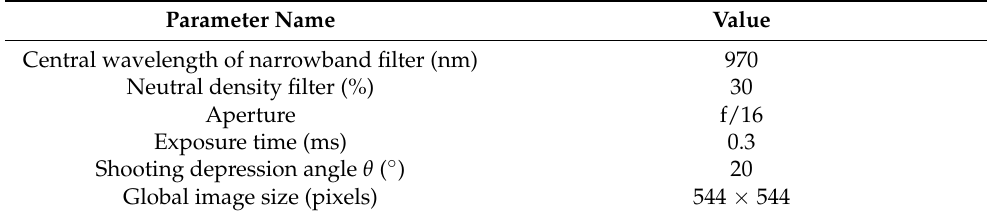
Table 1. Camera shooting conditions.